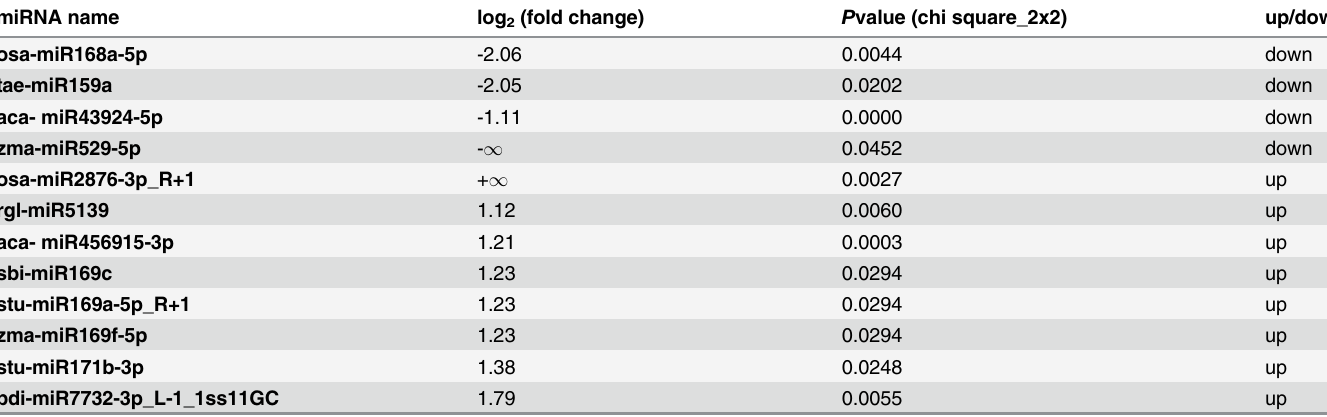
the two phases (Table 4). Among them osa-miR2876-3p_R+1 was preferentially expressed in the lag phase and zma-miR529-5p was only expressed in the logarithmic phase. The other 10 miRNAs were expressed in both libraries. Compared with the lag phase cultures, four miRNAs were significantly down-regulated and eight miRNAs were up-regulated in the logarithmic phase algae. Of the12 sequences, the majority ranged from a 1- to 2-fold difference, and only four miRNAs showed greater than 2-fold differences between the two growth stages. Some of the miRNA families were expressed solely in the lag phase or the logarithmic phase. For example, miR1862 (with one copy), miR1507, and miR947 were expressed exclu- sively in the lag stage, whereas miR535, miR820, and miR529 were only expressed in the loga- rithmic stage. These significant result ssuggested that these families may have potentially important effects on the initial and exponential growth stages, respectively. Table 4. Twelve differentially expressed miRNAs in two different growth phases in A . catenella